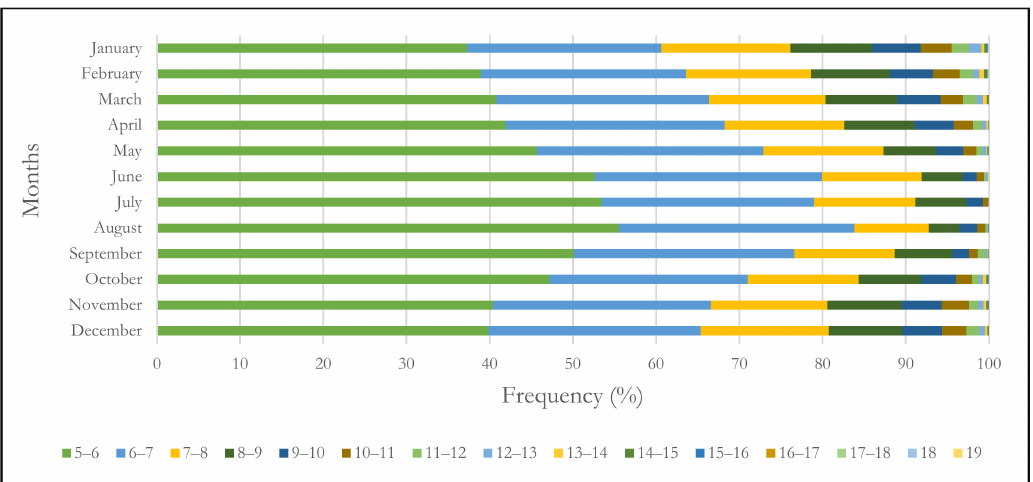
Figure 6. Frequency of monthly Uer occurrence within the study